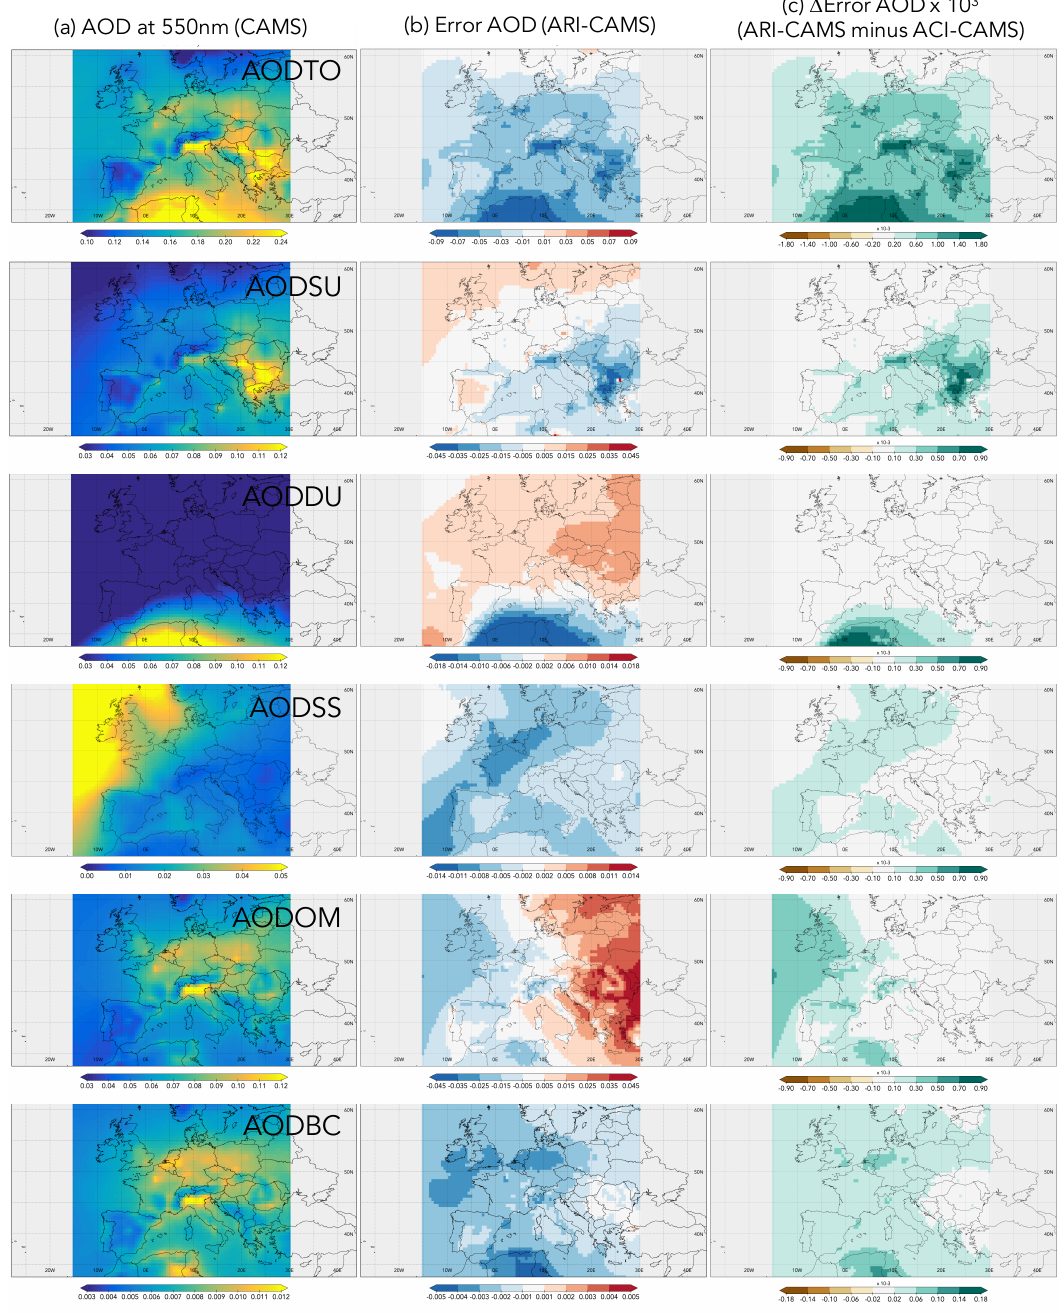
Figure 3. (From top to bottom: AODTO, AODSU, AODDU, AODSS, AODOM, AODBC). ( a ) CAMS reanalysis climatology of AOD at 550 nm. ( b ) Error (bias) of the simulation for the base case and (ARI). ( c ) Improvement of the error with respect to the base case simulation when including ACI. A positive number, represented by green colours, indicates a reduction of the absolute error in ACI simulations with respect to the base